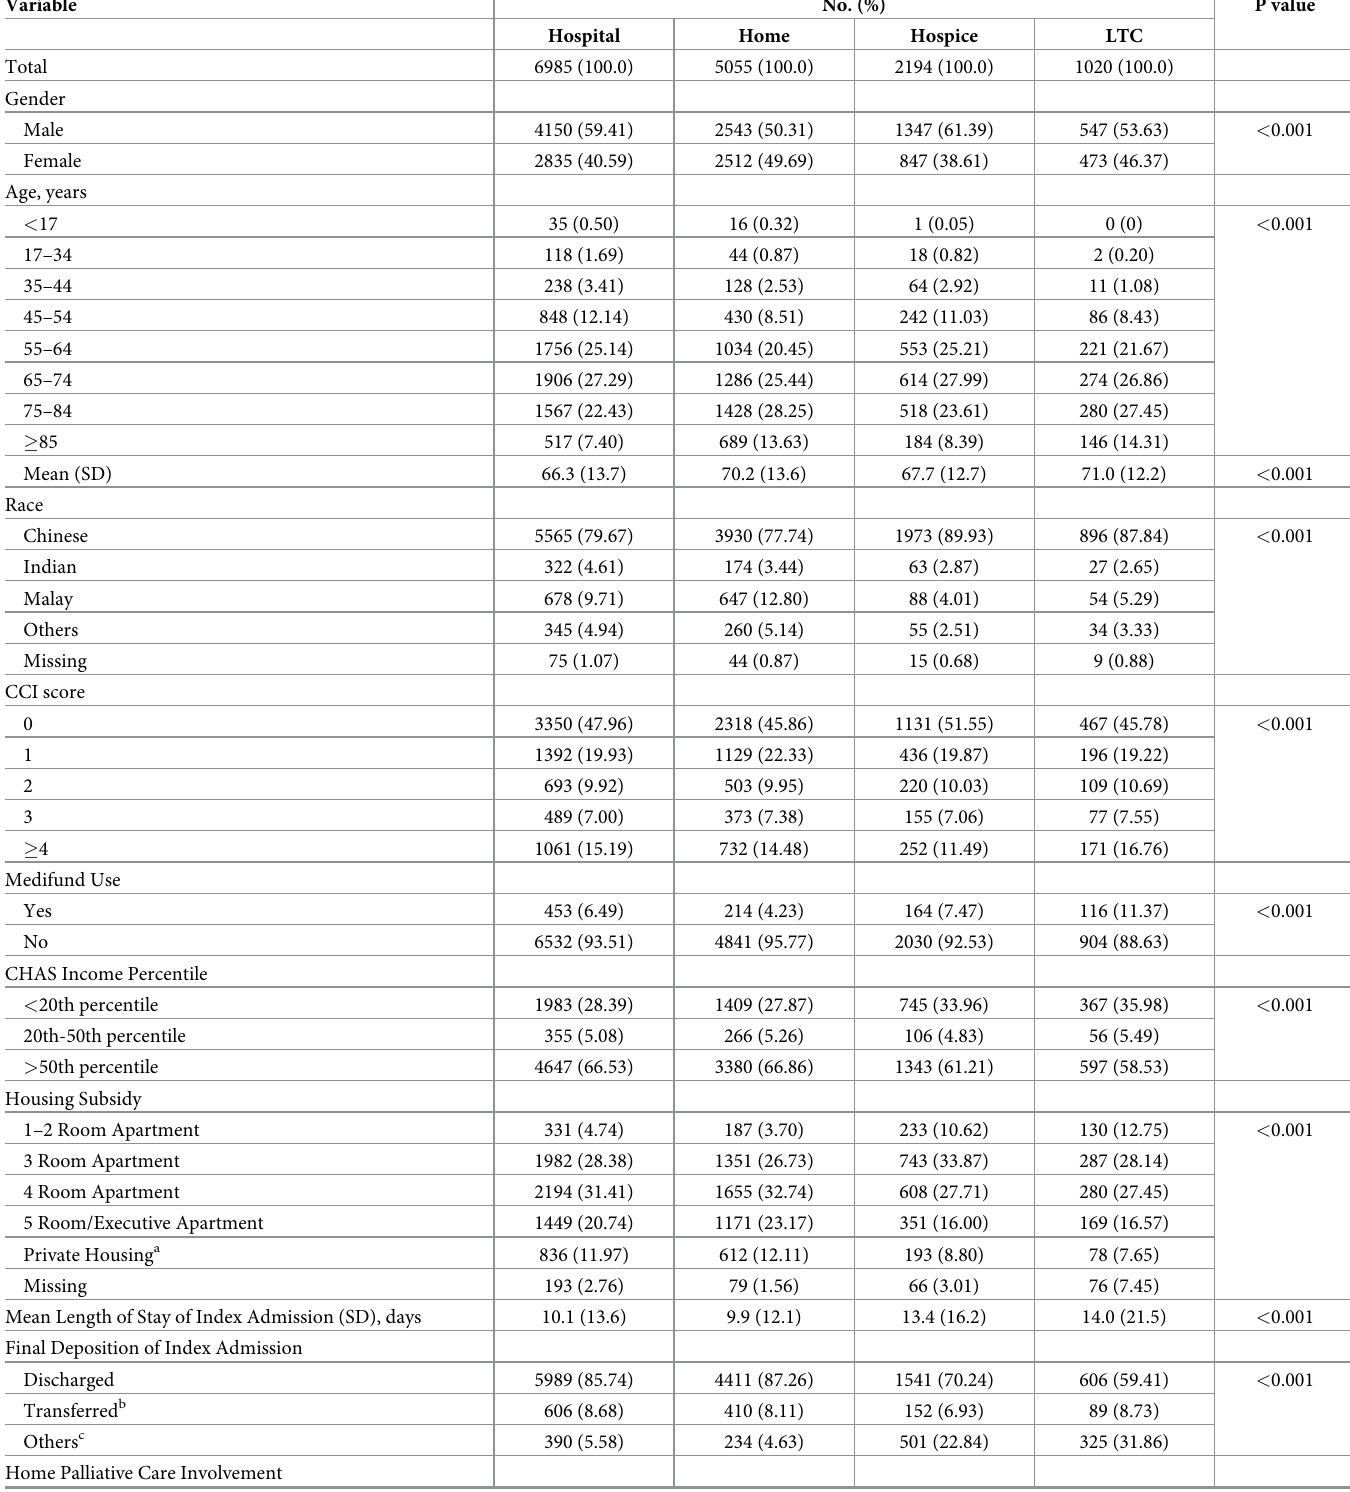
Table 1. Sociodemographic and clinical characteristics of decedents by place of